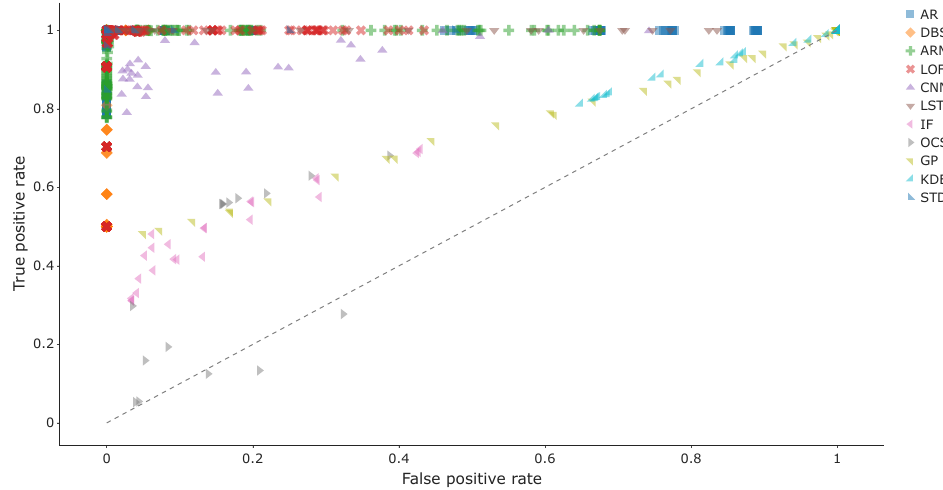
Figure 10. Results of the anomaly detection models based on synthetic data set 1.